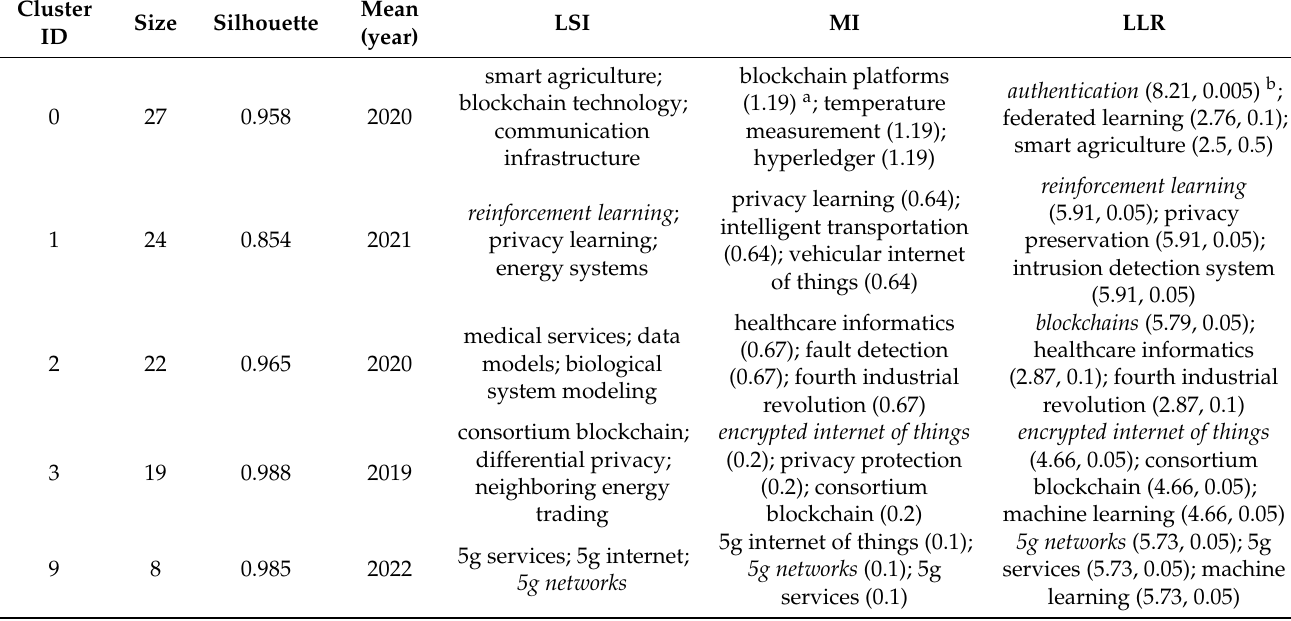
Table A1. Summary of the largest co-authorship clusters in the subject